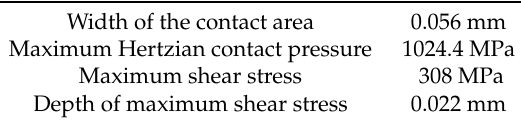
Table 4. Results obtained with the Hertz theory.